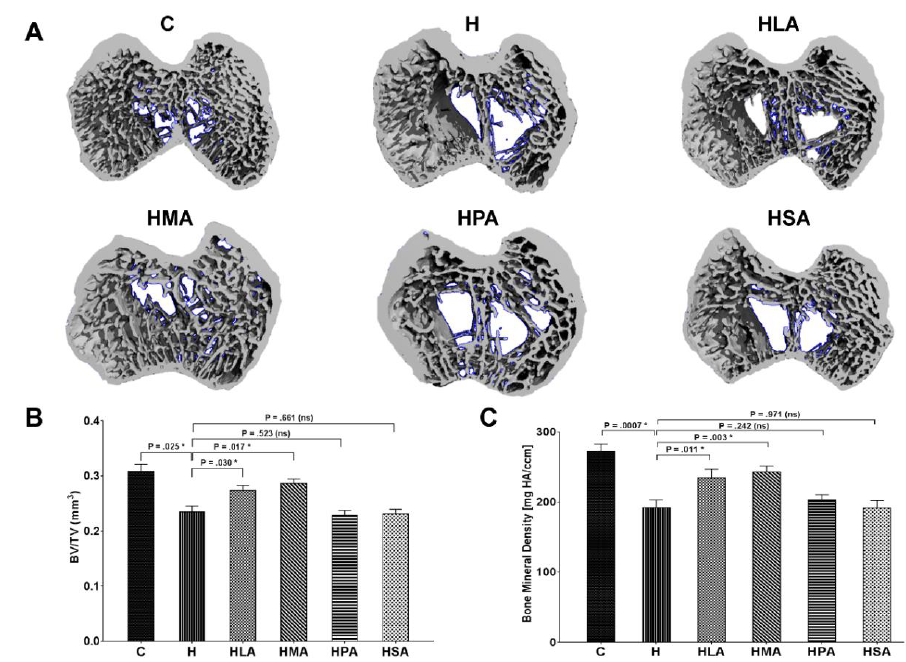
Figure 3. Bone volumetric analysis. ( A ) Reconstructed axial micro-CT cross-section images of the medial and lateral tibial plateau (ROI) of the knees of rats fed the different diets. For morphometric analysis, ( B ) the bone volume fraction (BV / TV) was calculated as the ratio of segmented bone volume (BV) to the total volume (TV) of the ROI. In addition, ( C ) the bone mineral density (BMD) of the ROI was also calculated. All values are represented as mean ± SD, n = 6. ROI, Region of interest. C, corn